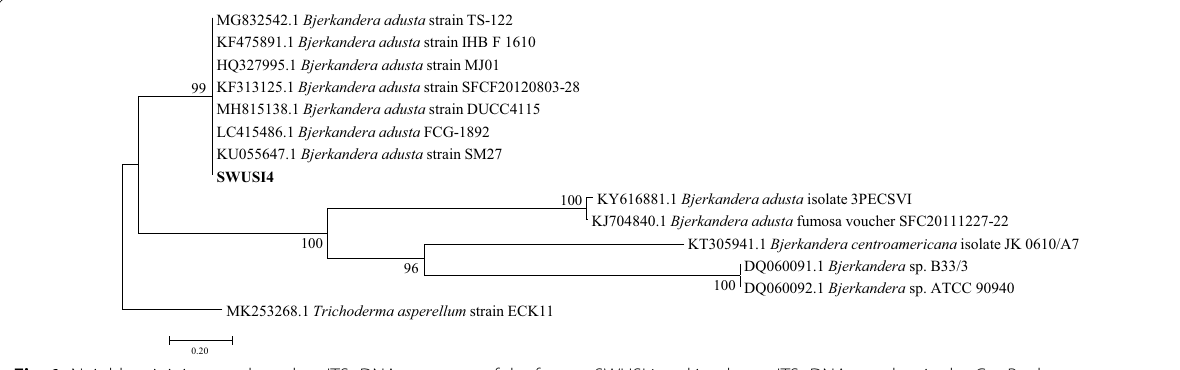
Fig. 1 Neighbor-joining tree based on ITS rDNA sequence of the fungus SWUSI4 and its closest ITS rDNA matches in the